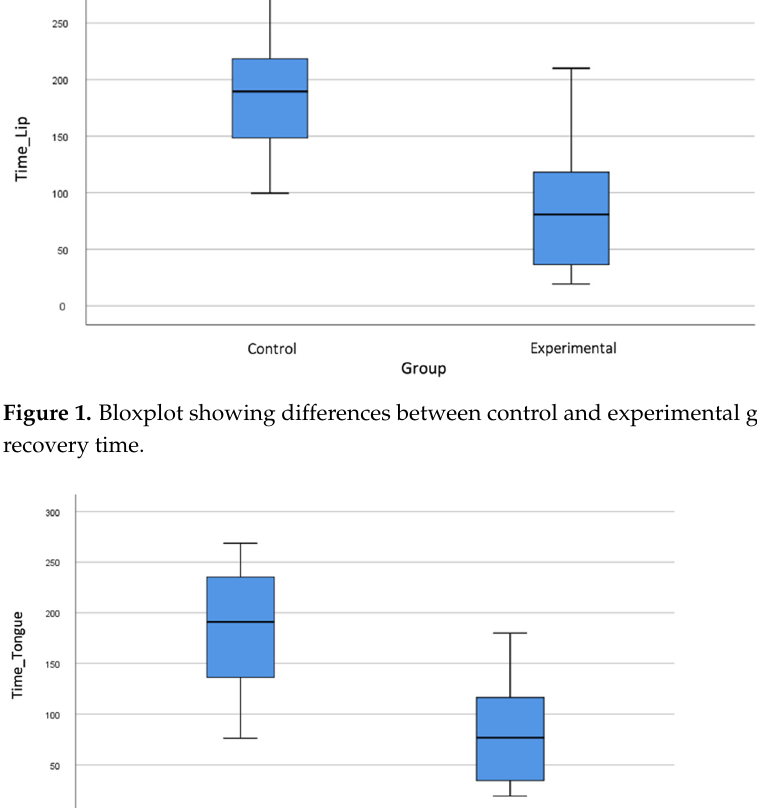
Figure 4. Percentage of patients who used analgesics. An analysis of the postoperative clinical questionnaire collected at 24 h (Table 2) showed statistically significant differences in relation to difficulty in chewing ( p = 0.01) and accidental bites ( p = 0.05), which were greater in CG. On the contrary, greater pain in the anaesthetic area was recorded in EG ( p = 0.043). Regarding possible adverse effects of OraVerse ® , no statistically significant values were observed between the two groups. Speech impairment ( p = 0.633), nausea ( p = 0.402), feeling of palpitation or dizziness ( p = 0.31) and head or neck pain ( p = 0.393) did not differ between the two groups.